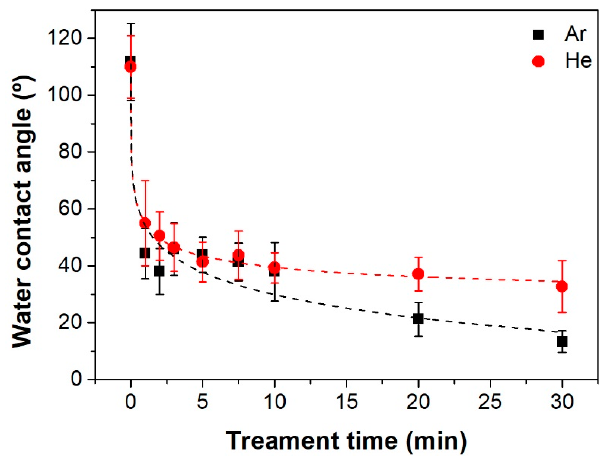
Figure 6. Water contact angle of wheat seeds treated for different treatment times from 1 to 30 min using an argon (black curve) and helium (red curve) discharge. Gas control values for both gases are in the same range as the control points: argon control is 107 ˚ ± 12 ˚ and helium control is 111 ˚ ± 9 ˚ . Curves were fitted with a logistic function.